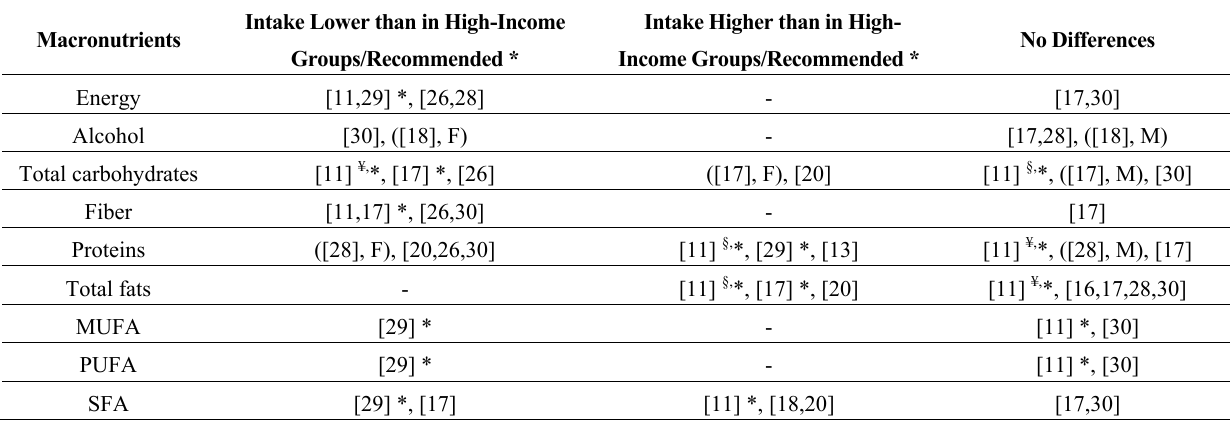
Table 3. Summary of reported findings on nutrient intake among low-income populations from the included